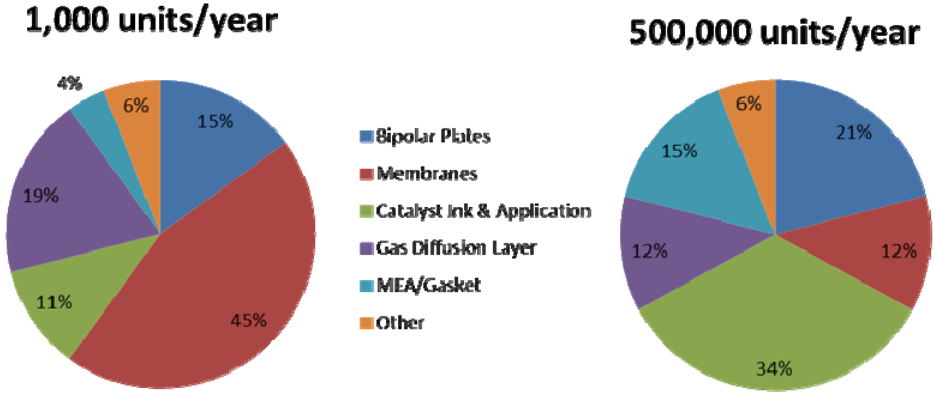
Figure 1. Comparison of the fractional contribution to the fuel cell stack at production rates of 1000 and 500,000 units per year [4]. At low production volumes, membrane costs account for as much as 45% of the total cost of the